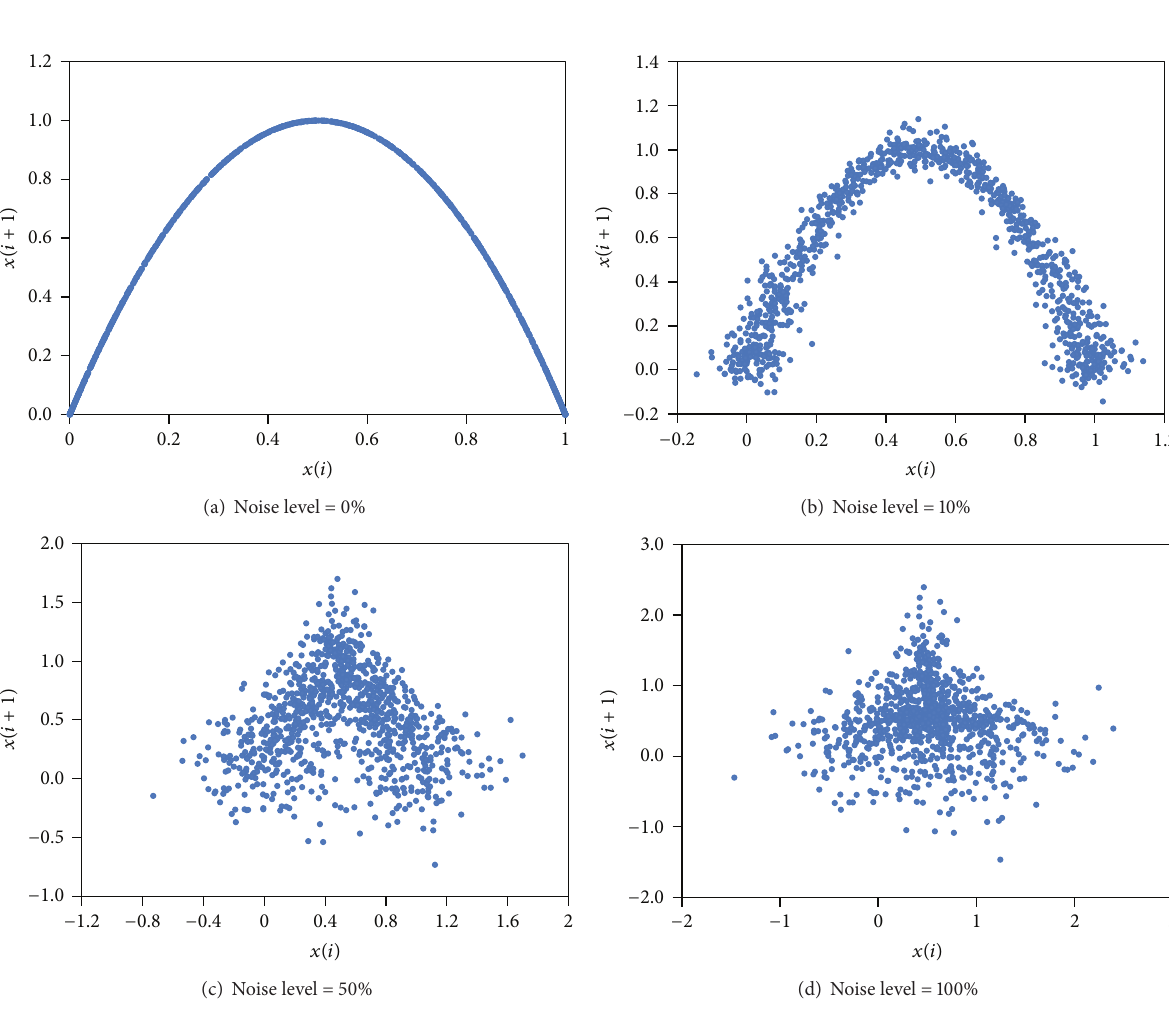
Figure 2: The attractors with the noise